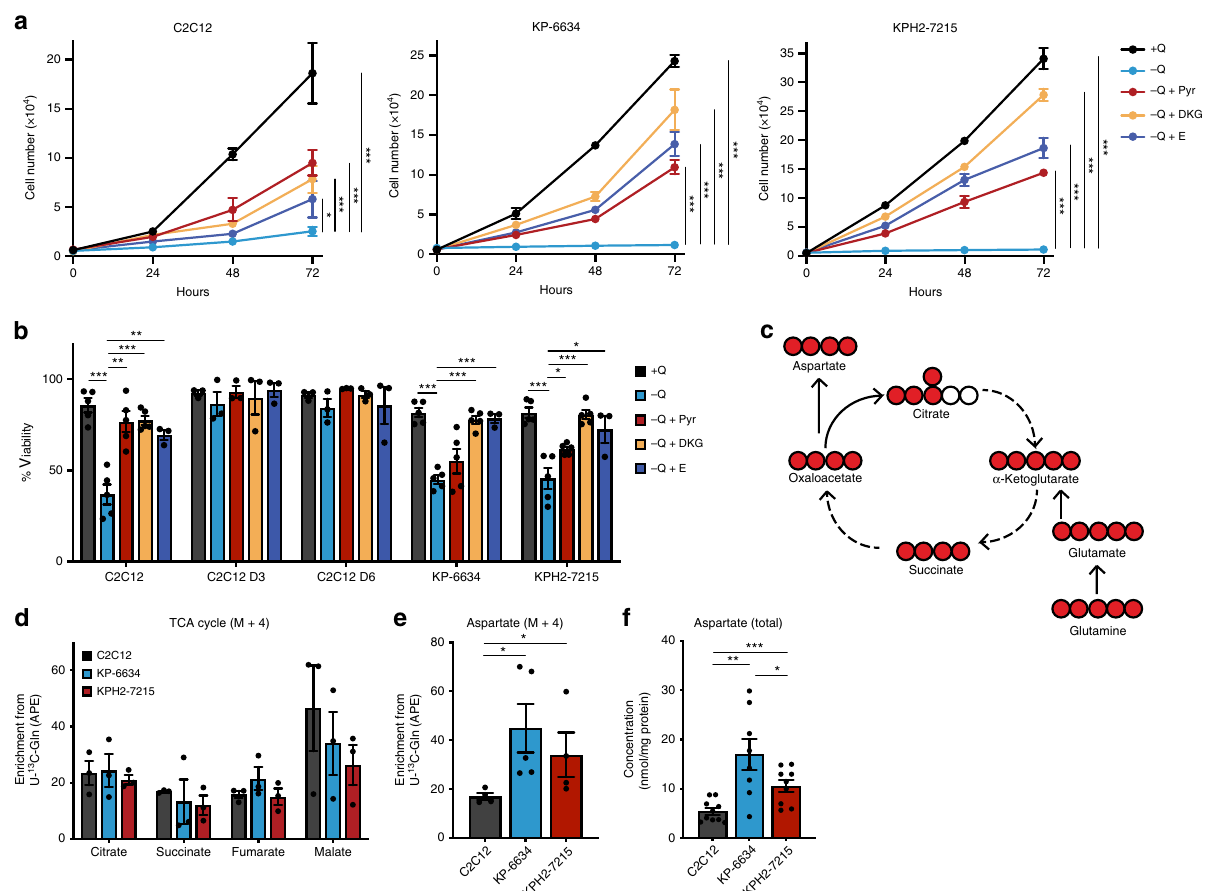
Fig. 2 UPS tumours cells maintain glutamine anaplerosis. a Proliferation of C2C12s, KP-6634s, and KPH2-7215s (left to right) grown in media with or without glutamine (Q), supplemented with 5 mM pyruvate (Pyr), 5 mM dimethyl 2-oxoglutarate (DKG), or 2 mM glutamate (E). N = 3 with three technical replicates. Data represent mean ± s.e.m.; * p < 0.05, *** p < 0.0005. b Viability of C2C12, C2C12 D3, C2C12 D6, KP-6634, and KPH2-7215 cells grown in media with or without Q, supplemented with 5 mM Pyr, 5 mM DKG, or 2 mM E and assessed after 48 h. N = 3 with two technical replicates. Data represent mean ± s.e.m.; * p < 0.05, ** p < 0.005, *** p < 0.0005. c Schematic depicting the TCA cycle and production of aspartate. Filled red circles represent 13 C atoms derived from U- 13 C-glutamine. d Mass isotopomer analysis of M + 4 enrichment in citrate, succinate, fumarate, and malate, represented as atom percent excess (APE), in C2C12s, KP-6634s, and KPH2-7215s cultured for 5 h with U- 13 C-glutamine. N = 3 with two technical replicates. Data represent mean ± s.e.m. e Mass isotopomer analysis of M + 4 enrichment in aspartate, represented as APE, in C2C12s, KP-6634s, and KPH2-7215s cultured for 5 h with U- 13 C-glutamine. N = 3 with two technical replicates. Data represent mean ± s.e.m.; * p < 0.05. f Total aspartate levels in C2C12s, KP-6634s, and KPH2-7215s via HPLC. N = 4 with two technical replicates. Data represent mean ± s.e.m.; * p < 0.05, ** p < 0.005, *** p < 0.0005. p -Values were calculated from a two-tailed Student ’ s t -test for a , b , d – f . Source data are provided as a Source Data